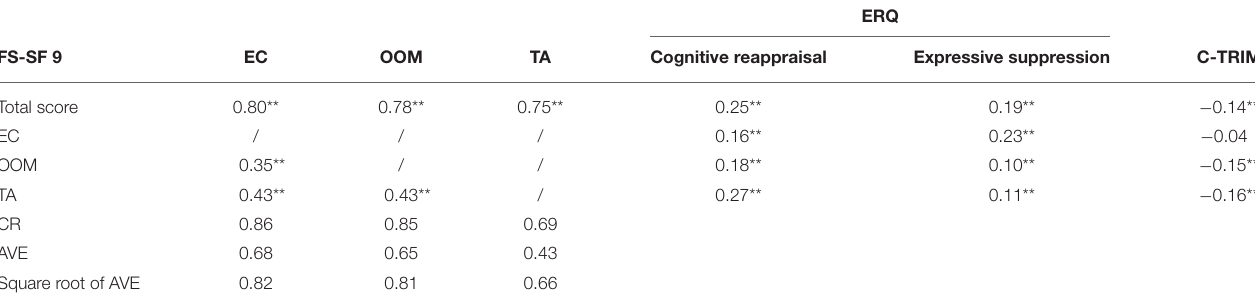
TABLE 6 | FS-SF 9 intercorrelation matrix, CR, AVE, square root of AVE of latent variable, and correlations between FS-SF 9 and emotional regulation, unforgiveness.